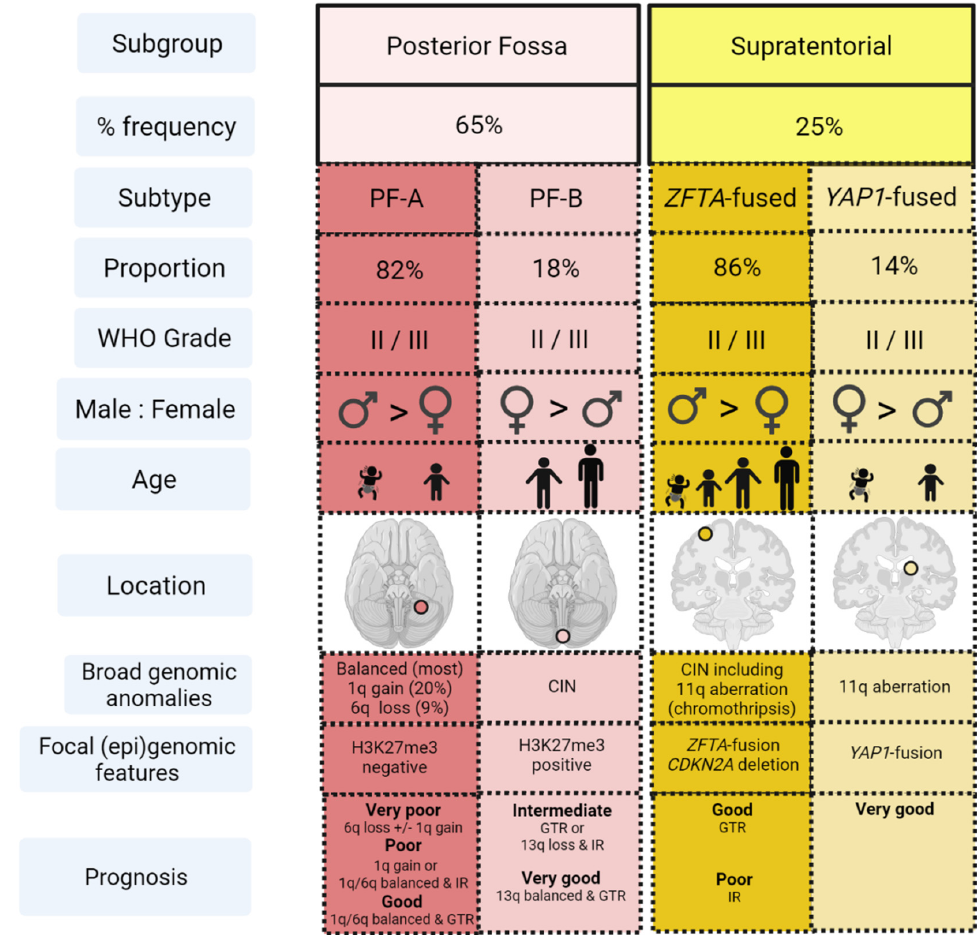
Figure 3. Predominant molecular subtypes of pediatric intracranial ependymoma. Posterior fossa and supratentorial childhood ependymomas are shown, further categorized into four in-group subtypes; PF-A, PF-B, ZFTA -fused and YAP1 -fused. The clinical and biological characteristics of these subtypes are shown, in accordance with [59,120,139–153]. Nine molecular subtypes of ependymoma are reported but the remaining subtypes occur in either the spinal cord (spinal sub- ependymoma, spinal myxopapillary ependymoma, spinal ependymoma) or the adult brain (subependymoma: PF and ST) so are not depicted in this figure. Age-related cartoons depict infant, young child (2–5 years), child (5–12 years), adoles- cent/adult (12+ years). Key: WHO = World Health Organization, CIN = chromosomal instability, GTR = gross total resec- tion, IR = incomplete resection.